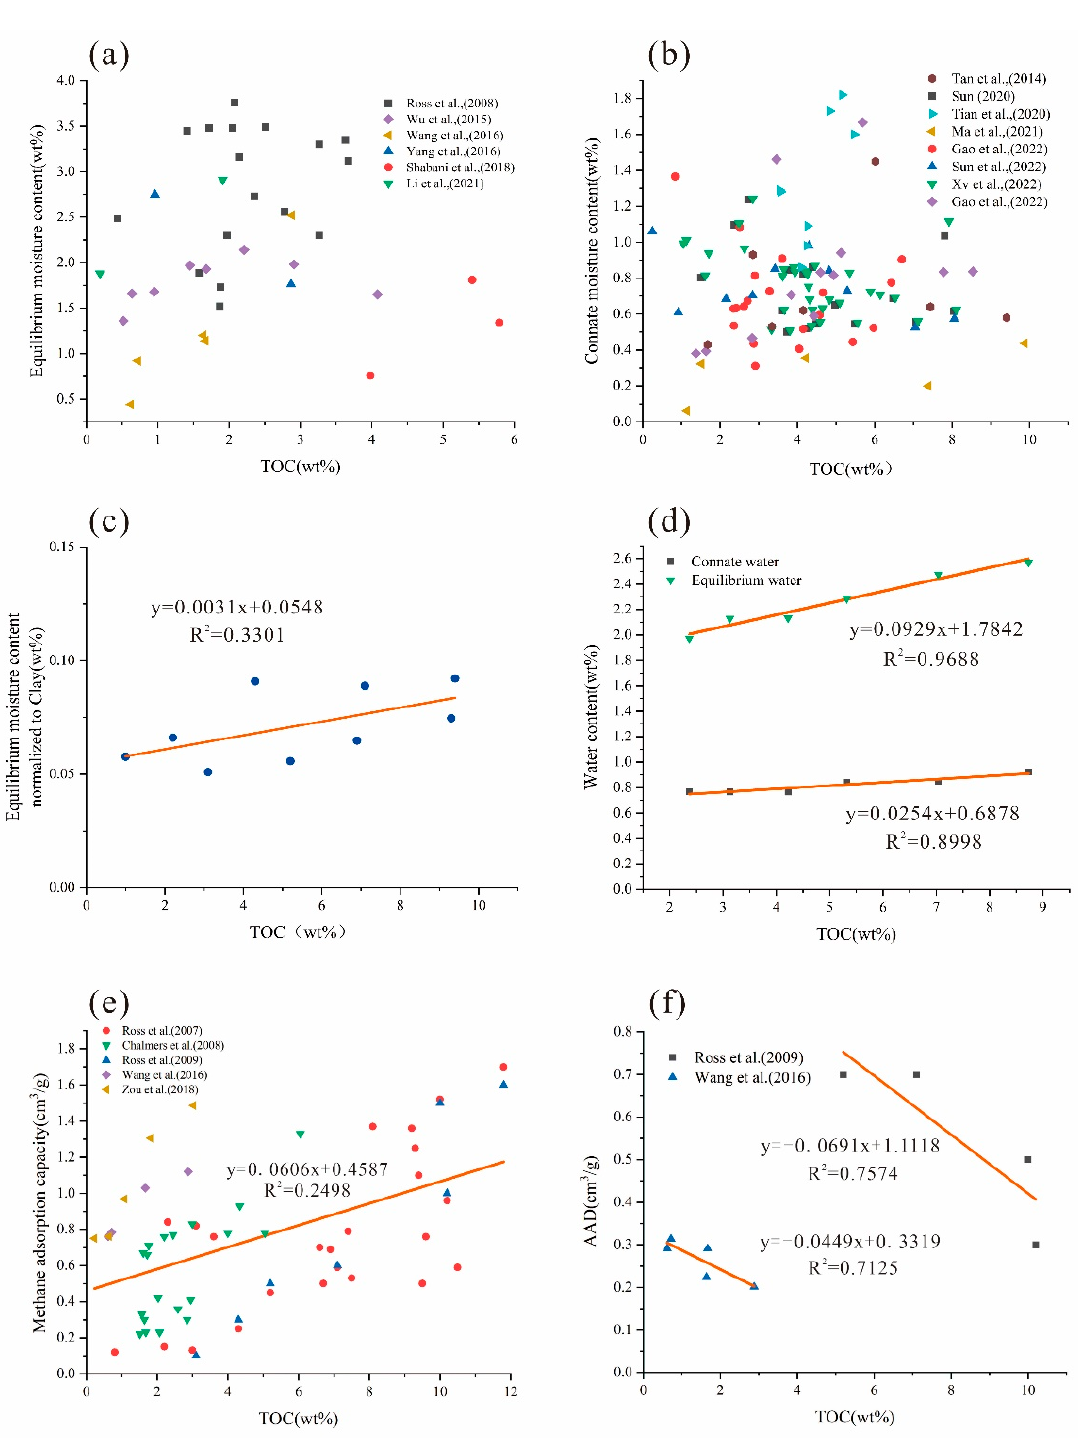
Figure 3. Relationships of TOC content with equilibrium moisture content, connate water content, methane adsorption capacity, and methane adsorption capacity differences between dry and moist conditions in shales. ( a ) TOC content versus equilibrium moisture content (Ro between 1.25% and 3.6%). The data of Ross and Bustin (2008) are derived from the Muskwa shale in the northwestern region of the Western Canada sedimentary basin [85]. The data of Wu et al. (2015) are derived from the Longmaxi Formation shale from the XY1 well in Guizhou and the outcrops of Fenghuang and Yongshun in Hunan, China [129]. The data of Wang and Yu (2016) are derived from the Carboniferous Keluke Formation shale from the CY2 well in the Qaidam Basin, China [88]. The data of Yang et al. (2016b) are derived from the Wufeng-Longmaxi Formation shale in the Sichuan Basin, China [91]. The data of Shabani et al. (2018) are derived from the Sargelu-Garau Formation shale in south- western Iran [130]. The data of Li et al. (2021b) are derived from the Shanxi-Taiyuan Formation shale